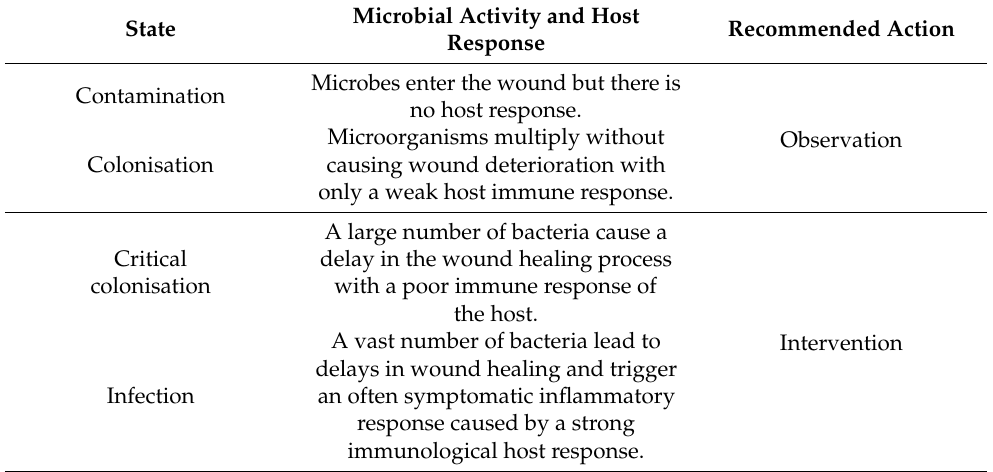
Table 1. Microbial states of the infected wound [18,19]. Microbial Activity and Host State